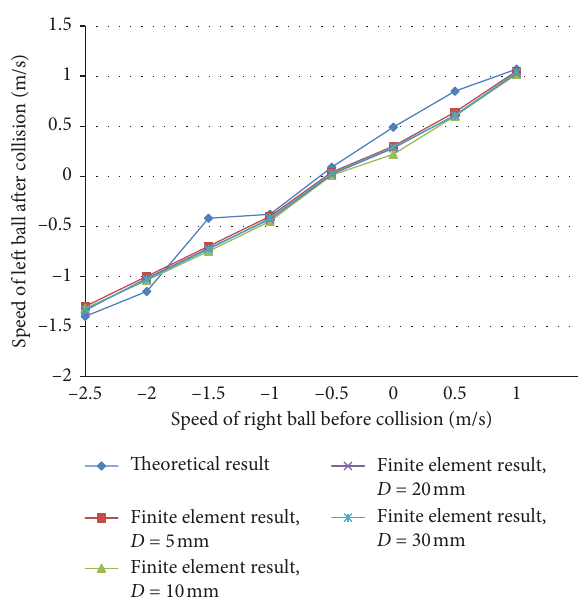
Figure 6: Relationship between the after-collision speed of the left ball and the before-collision speed of right